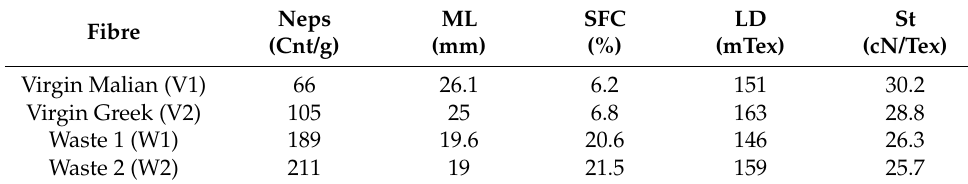
Table 1. Fibre properties.